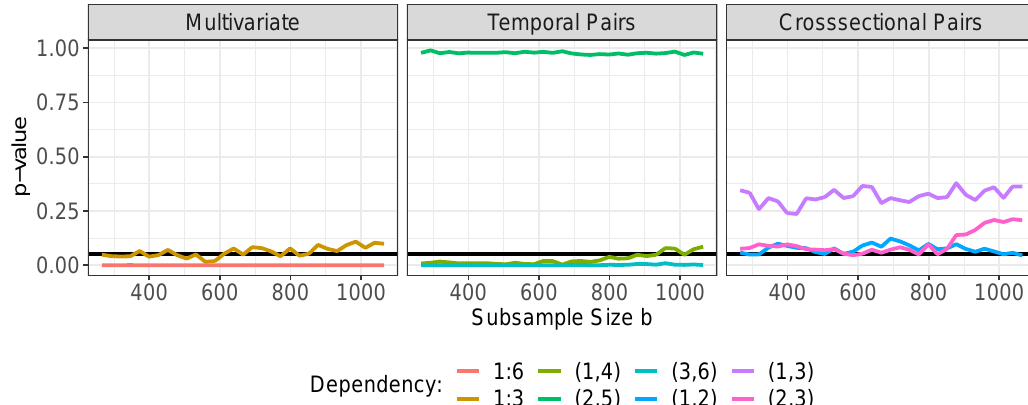
Figure 3: P-values as a function of the block size b for the eight hypotheses described in Section